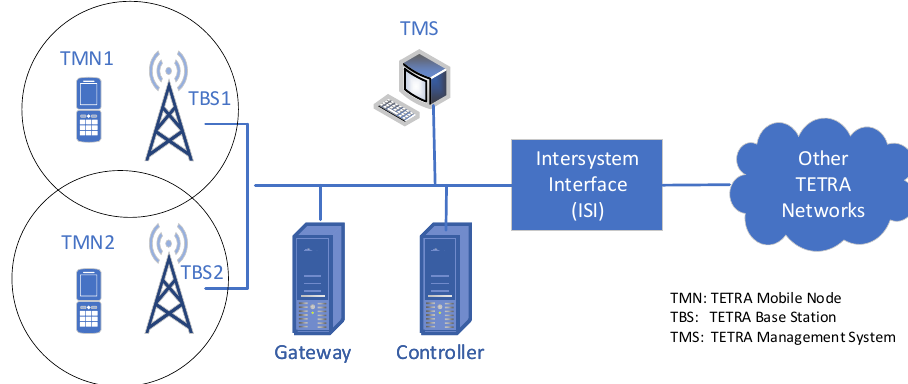
Figure 1. TETRA network